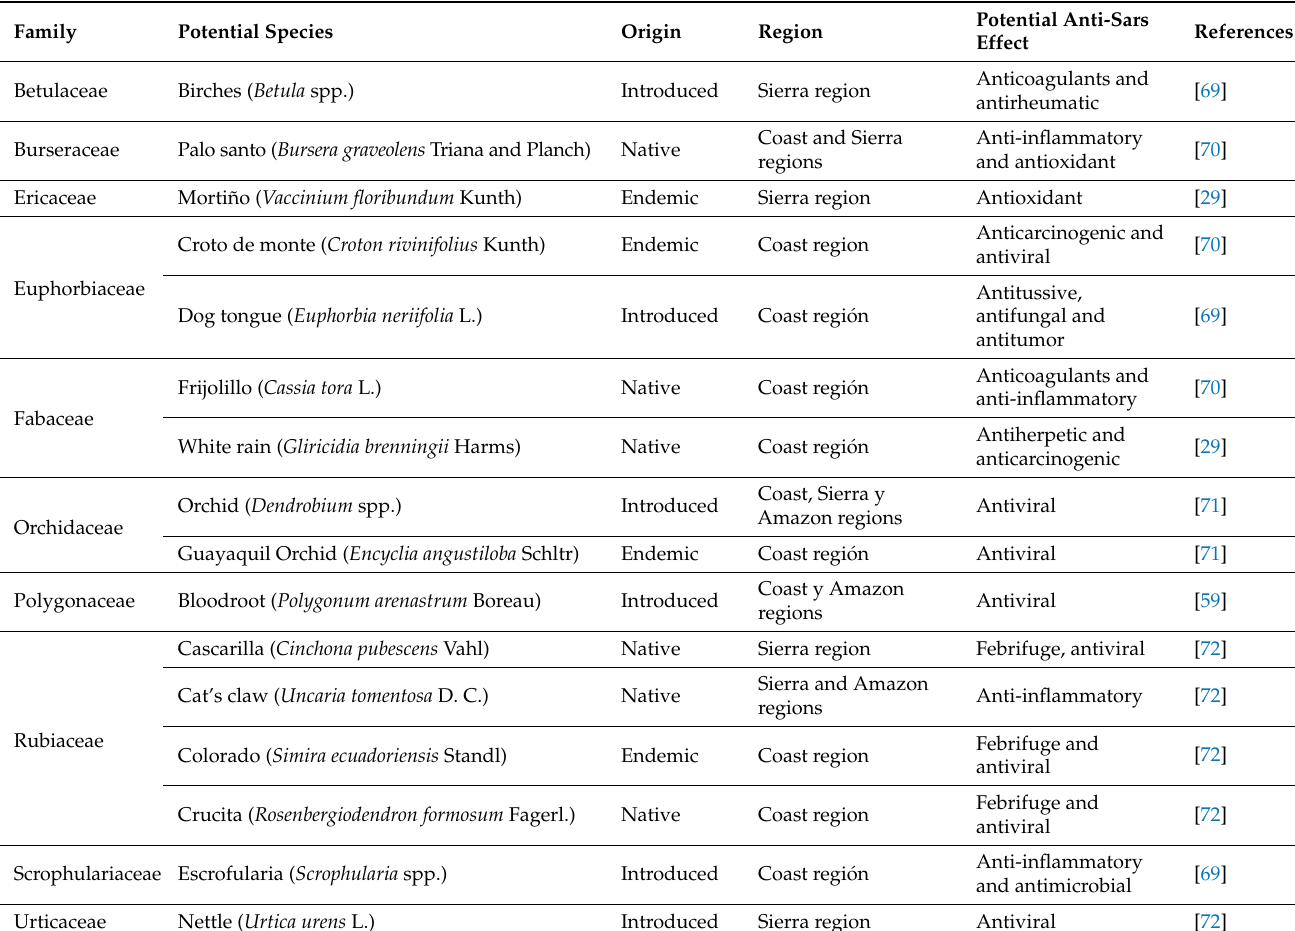
Table 4. Plant species with potential for the bioprospecting of secondary metabolites located in